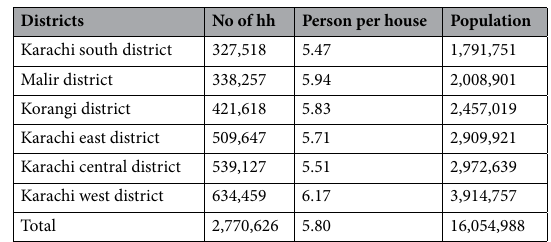
Table 1. Overview of the district-wise number of Households (hh), Persons per house, and population in Karachi (Census, 2017).